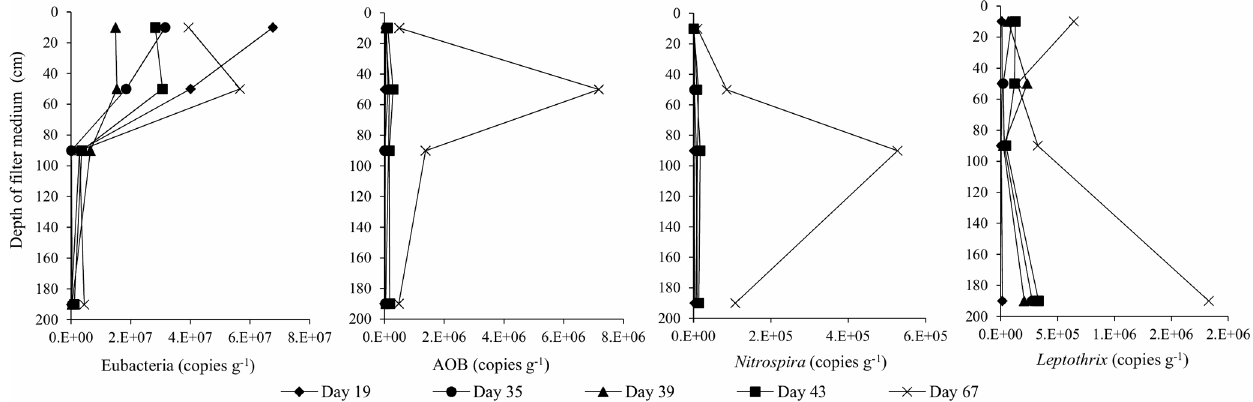
Figure 7. Depth profiles for qPCR results of filter media samples from Filter